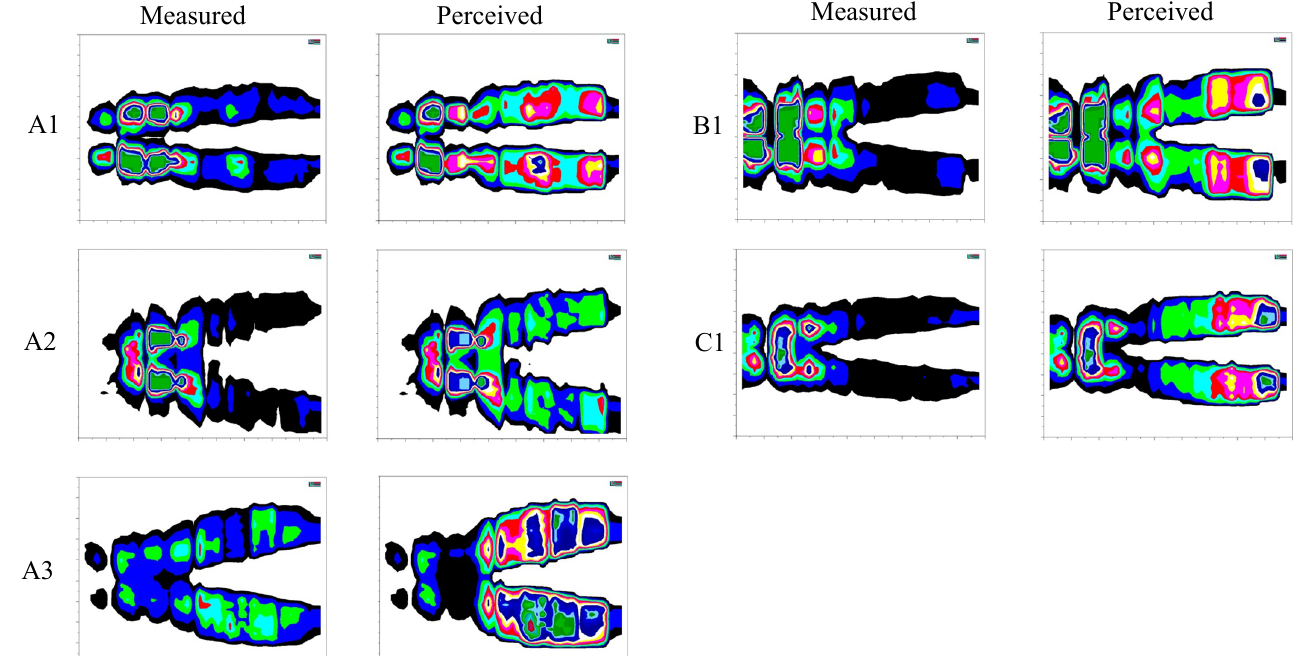
Figure 13. Measured comfort pressure distribution and perceived pressure distribution.